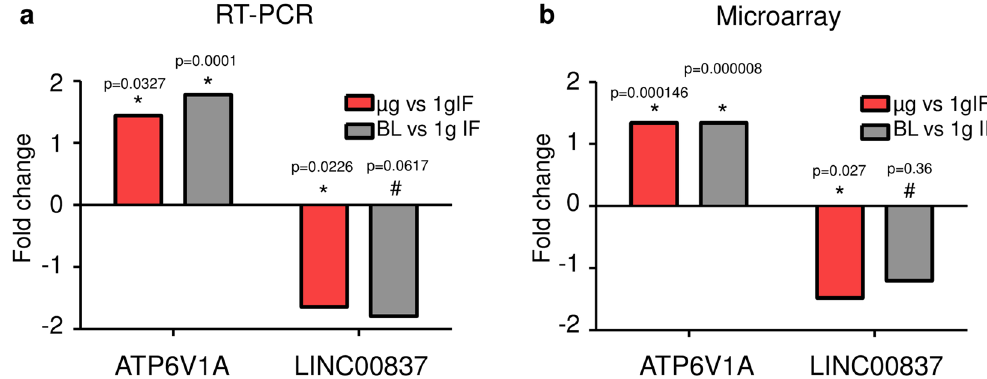
Figure 12. Quantitative real-time PCR validation of microarray expression data of ATP6V1A and LINC00837 for the TEXUS-51 suborbital rocket flight experiment. RNA samples used fo the microarray analysis were analyzed additionally by quantitative real time PCR as second independent method. ( a ) Microarray analysis: Significantly differential gene expression of ATP6V1A could be confirmed in microgravity ( µ g) versus 1 g in - flight (1 gIF) and in hypergravity (baseline BL) versus 1 g in - flight (1 gIF). Significantly differential gene expression of LINC00837 could be confirmed in microgravity ( µ g) versus 1g in - flight (1gIF). ( b ) Quantitative real time PCR analysis. Significant differential gene expression value of the same magnitude were detected in quantitative real-time PCR analysis. Statistical significance was tested by ANOVA for microarray results and by T-test in case of qRT-PCR, n = 9 for 1g in - flight (1gIF), n = 7 for baseline (BL) and n = 9 for